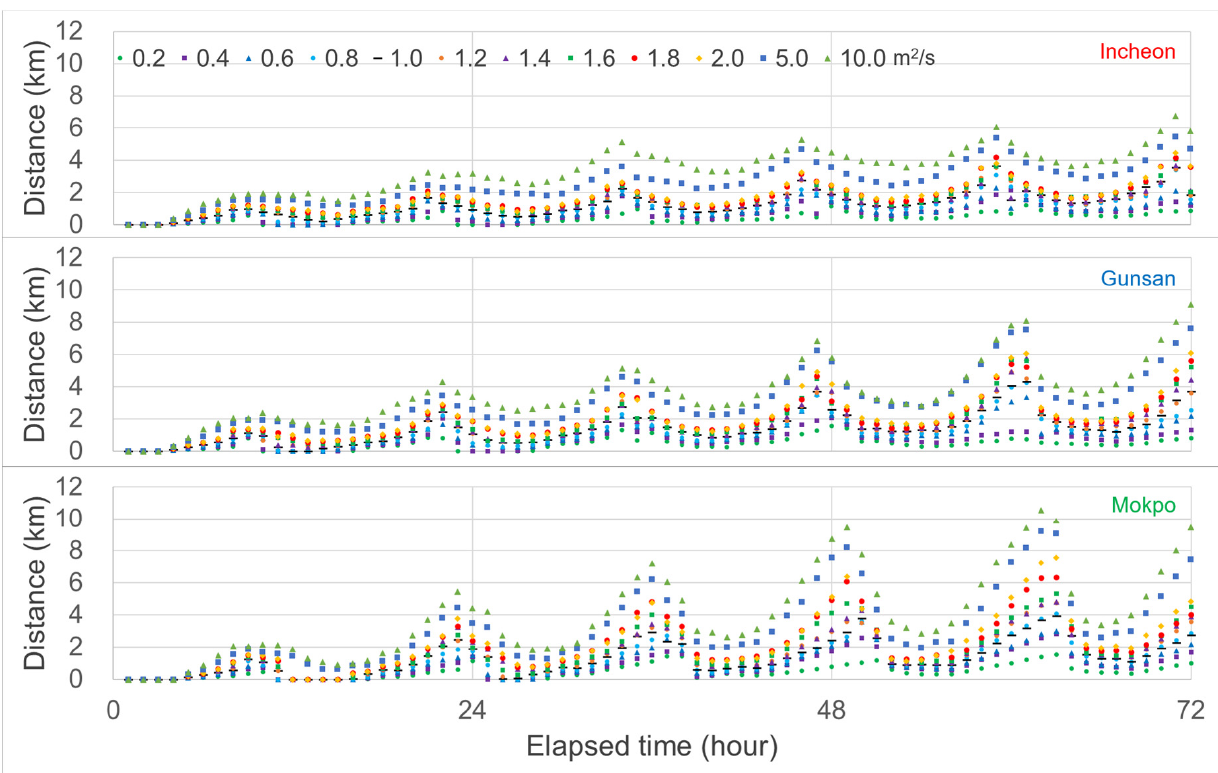
Figure 8. Temporal fluctuating particles regarding sensitivity tests for dispersion